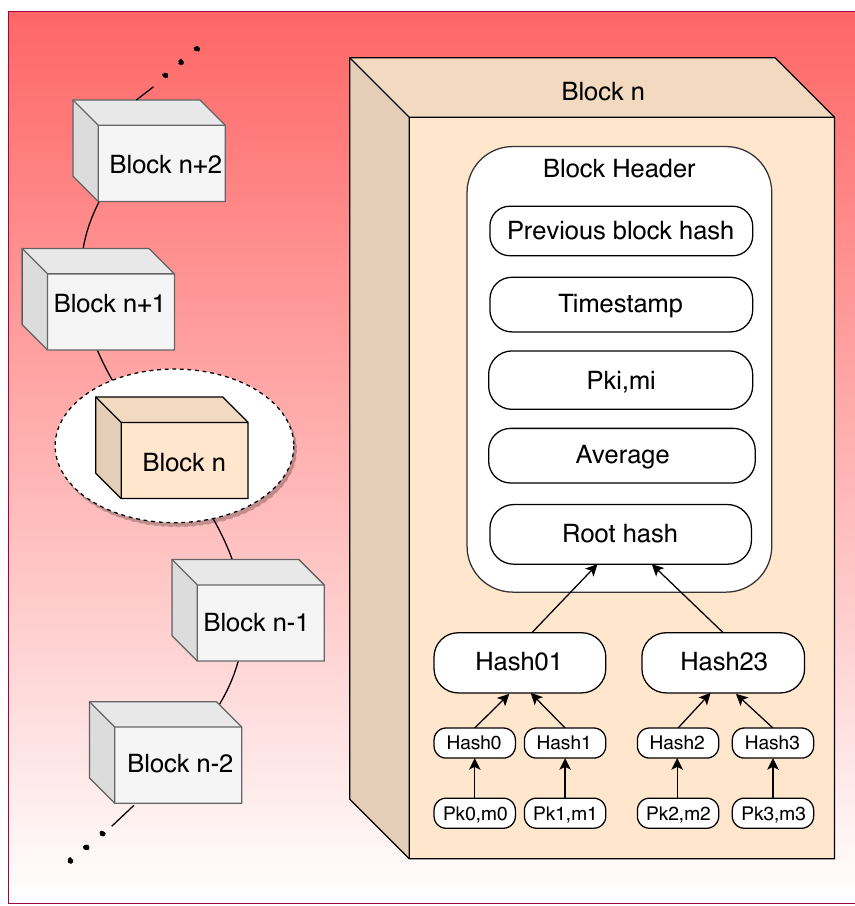
Figure 8. Block structure for data aggregation and privacy preservation